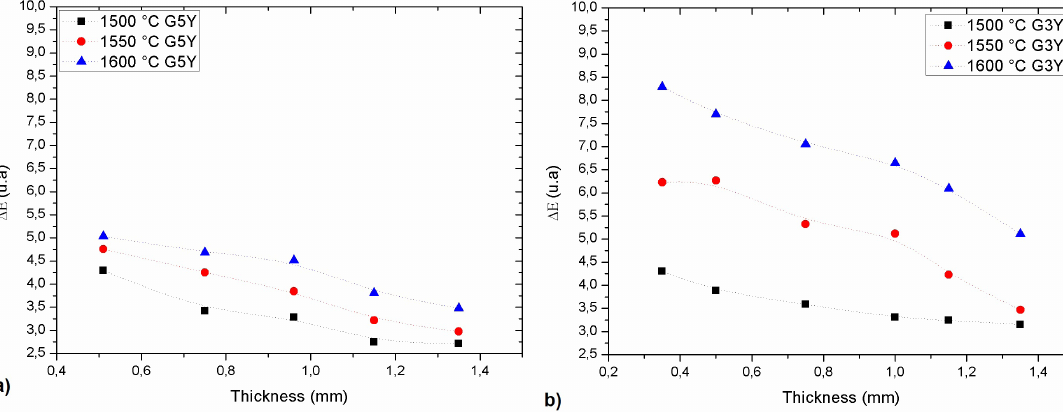
Figure 11. Color difference measured for the samples according to their thickness a) G5Y and b) G3Y.